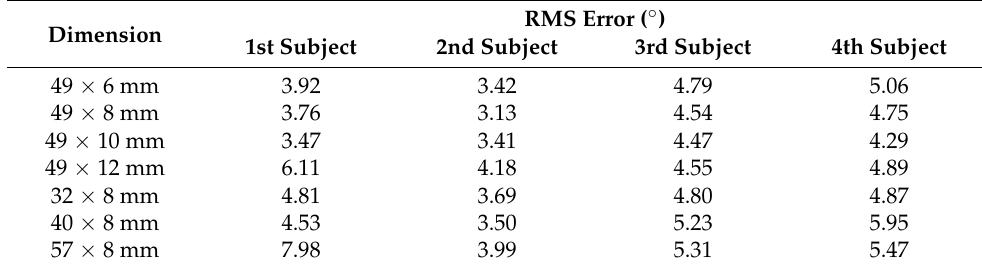
Table 4. RMS errors of each sensor from the results for each subject.